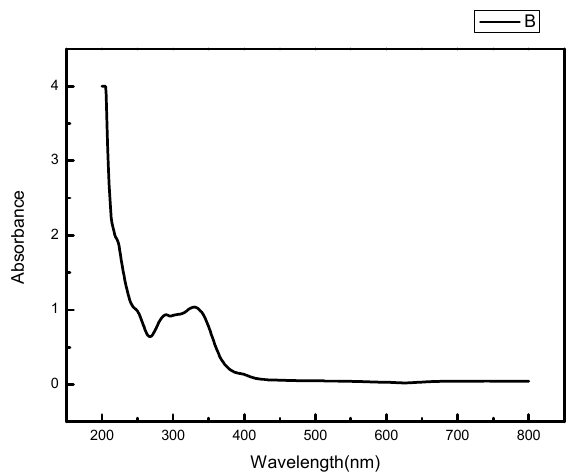
Figure 7. UV-Vis absorption spectrum of osmanthus extract.